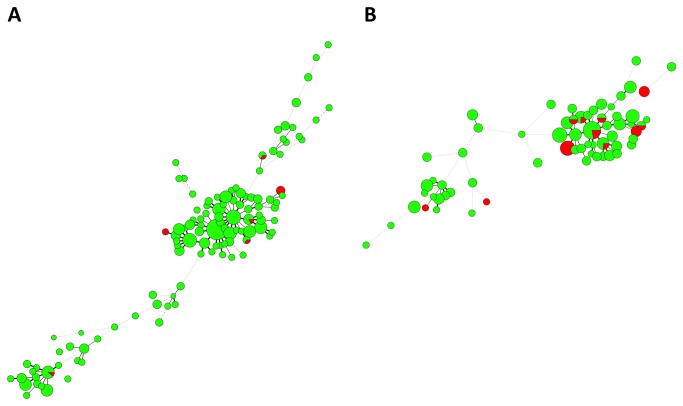
Minimum spanning trees of clustered MTC isolates categorized according to presence of MDR (green = non-MDR MTC, red = MDR MTC).Each circle represents a genotype and the sizes of the circles are proportionate to the number of members in each group. The distance between circles represents how closely related the different genotypes are to each other. 3A) MTC isolates from the earlier 2006-2007 phase. 3B) MTC isolates from the later 2008-2012 phase.